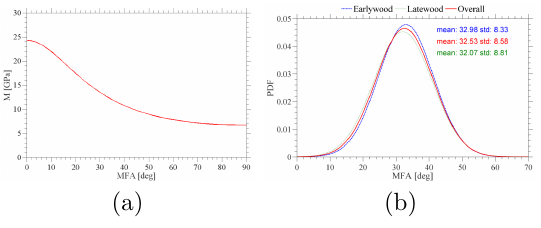
Figure 1. a) Variation of indentation modulus as a function of MFA, b) Probability density function of